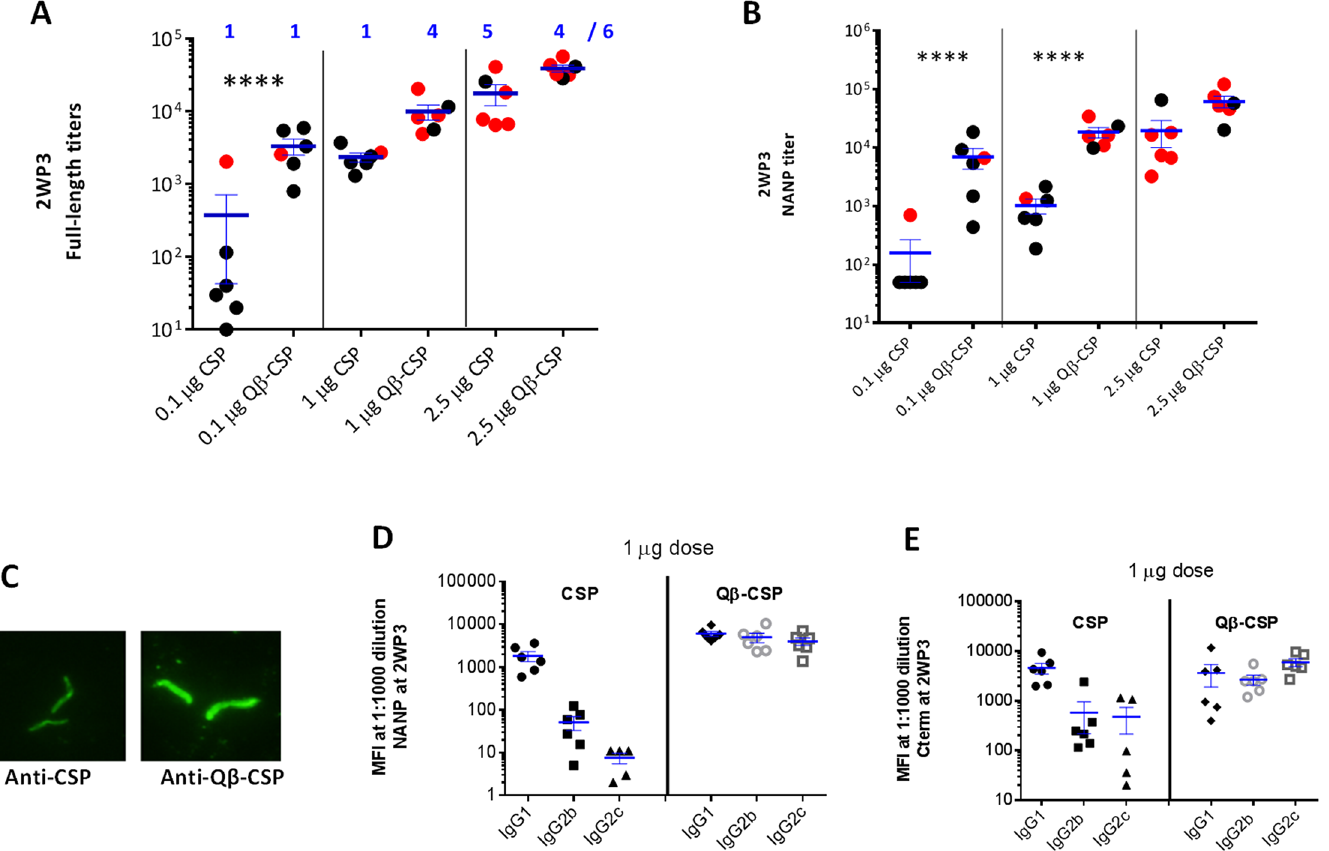
Fig 3. Q β -CSP vs . CSP in Montanide. Groups of 6 mice were vaccinated thrice with 2.5, 1 and 0.1 μ g CSP or Q β -CSP in Montanide. A, B show the individual data points and mean ± SEM titers against full-length protein (A) and NANP repeat peptide (B) 2 weeks post 3 rd vaccination (2WP3). **** (p < 0.0001 for ANOVA followed by Tukey ’ s multiple comparisons test); red data points correspond to mice protected 14 days post challenge and numbers (blue) were protected out of 6. C, Immunofluorescence image of methanol fixed sporozoites stained with 1:2500 dilution of anti-CSP pool (left) or Q β -CSP serum pool (right) for the 1 μ g dose groups. D, E show IgG1, IgG2b and IgG2c levels measured by Luminex and expressed as median fluorescence intensity (MFI) at 1:1000 serum dilution against the NANP peptide (D) or the C-term protein (E).